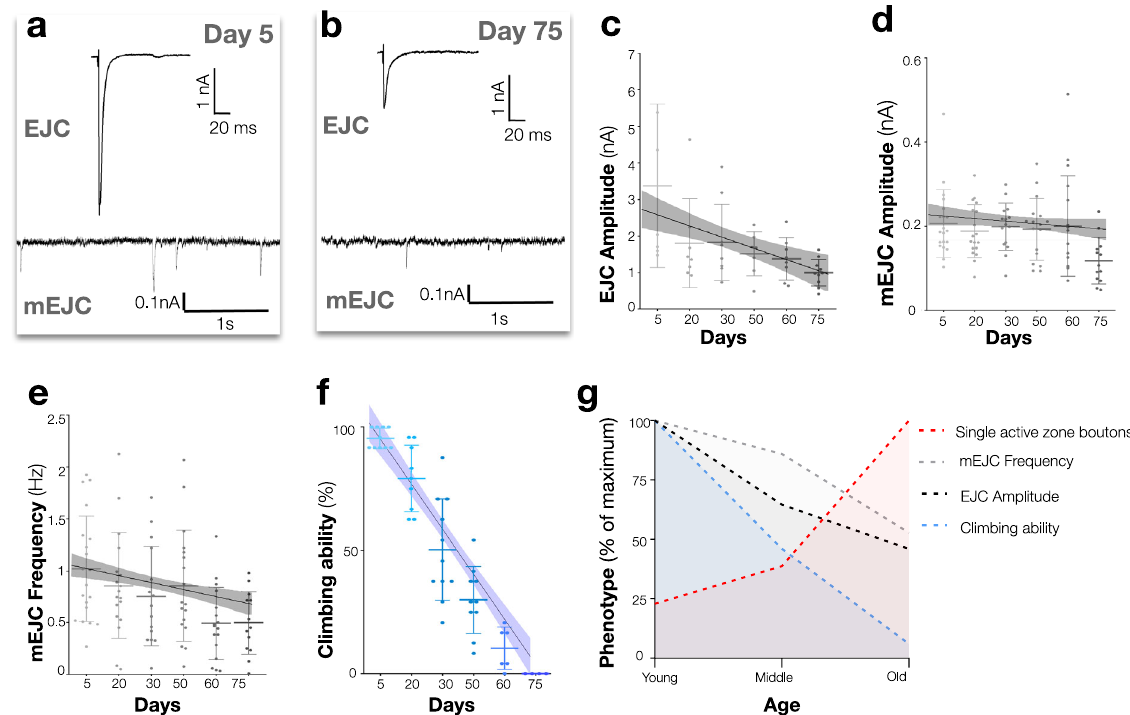
Fig. 2 Neurotransmission declines and motor behaviour is diminished during ageing. a , b Representative traces of excitatory junctional currents (EJCs) (above) and miniature excitatory junctional currents (mEJCs) (below) from 5-day-old and 75-day-old A2 mvim terminals. c Quanti fi cation of EJC amplitude decline during ageing. d Quanti fi cation of mEJC amplitude stability during ageing. e Quanti fi cation of mEJC frequency decline during ageing. f Quanti fi cation of declining motor ability during ageing. g Summary diagram indicates the progressive change of key ageing parameters as a percentage of the maximum observed phenotype. Compared to young animals (day 5) individual timepoints were signi fi cantly different at middle age (day 30) for increased bouton fragmentation, early old age (day 60) for EJC amplitude, early old age (day 60) for mEJC frequency and middle age (day 30) for motor ability. One-way ANOVA, ** p = 0.004, R 2 = 0.31, n ≥ 7 presynaptic terminals per timepoint ( c ), * p = 0.04, R 2 = 0.11, n ≥ 13 presynaptic terminals per timepoint ( d ), ** p = 0.004, R 2 = 0.15, n ≥ 13 presynaptic terminals per timepoint ( e ), *** p < 0.001, R 2 = 0.86, n ≥ 5 groups per timepoint ( f ), Tukey ’ s multiple comparison tests were used to compare the mean of each timepoint with the mean of all other timepoints (ns = not signi fi cant, * p ≤ 0.033, ** p ≤ 0.002, *** p ≤ 0.001). All statistical analyses with a precise value of ‘ n ’ are reported in Supplementary Table 2 and in Source Data fi le. Data are represented as mean ± SD. n = biologically independent